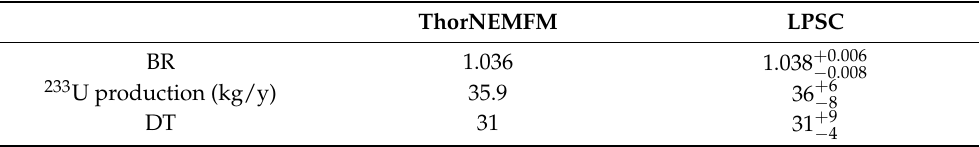
Table 3. Breeding performance of the